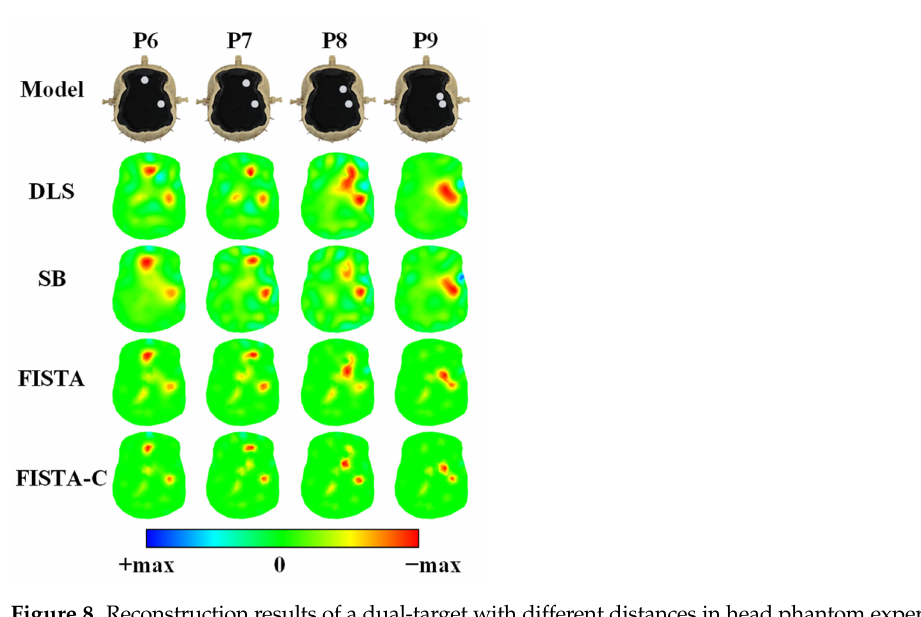
Figure 8. Reconstruction results of a dual-target with different distances in head phantom